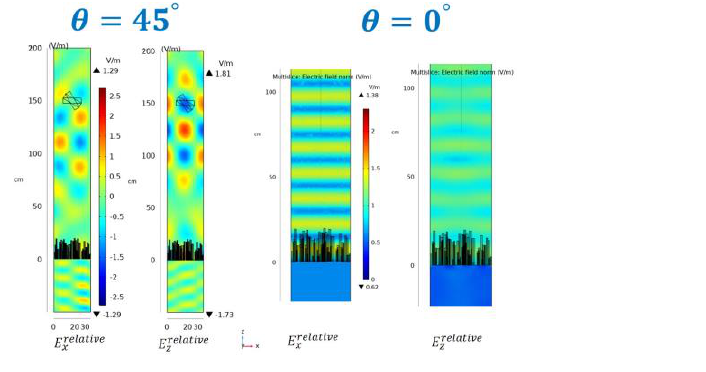
Fig. 3. The field distribution for incidence angels 45 and 0